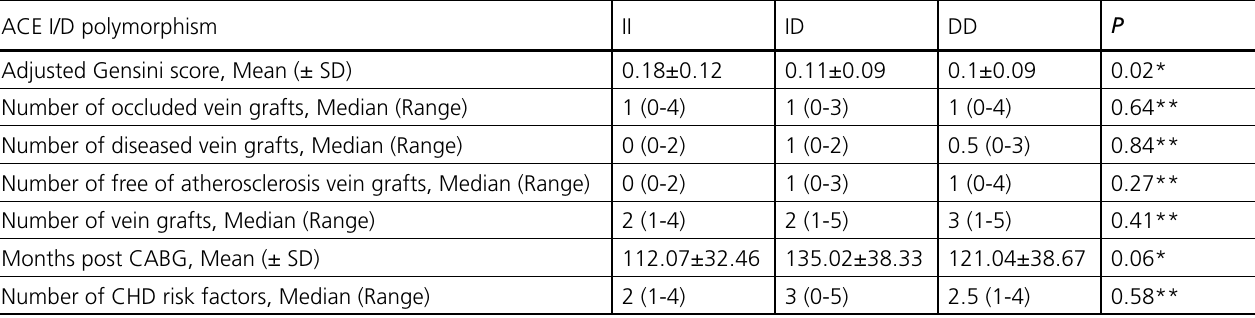
Table 3. Effect of ACE I/D polymorphism on progression of atherosclerosis in vein grafts of the studied